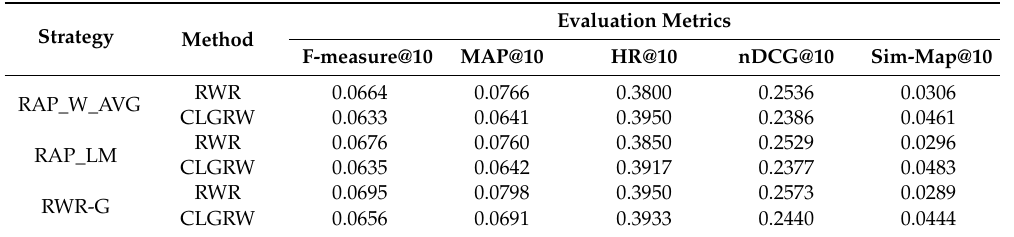
Table 4. Performance of RWR and CLGRW approaches and di ff erent group recommendation strategies including RAP_W_AVG and RAP_LM, and RWR-G on UU-VV (user and location neighborhood) graph (group size: two members).